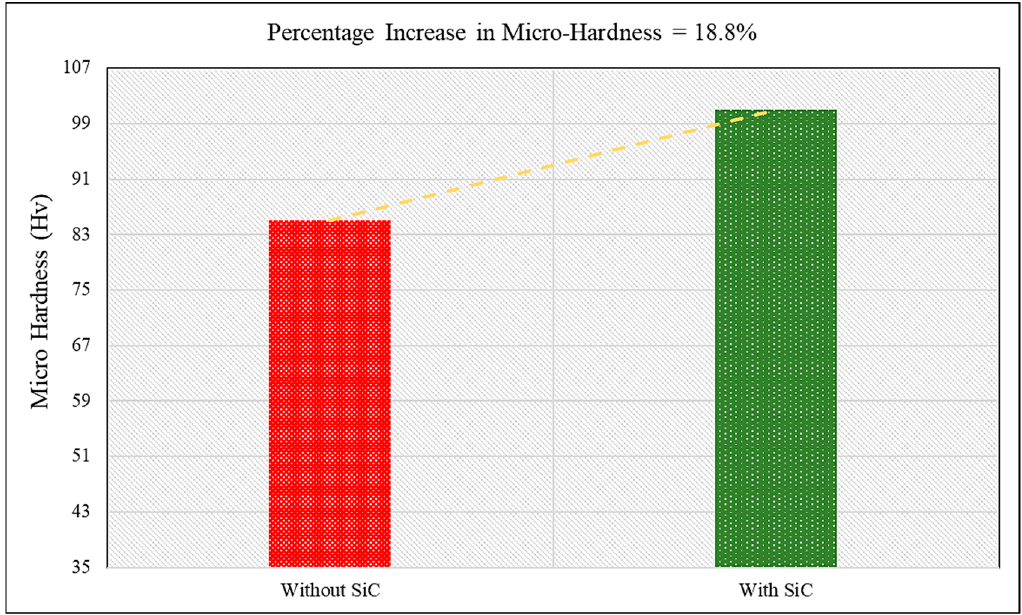
Figure 14. Comparative analysis of the micro-hardness of FSS welds without SiC and with SiC.